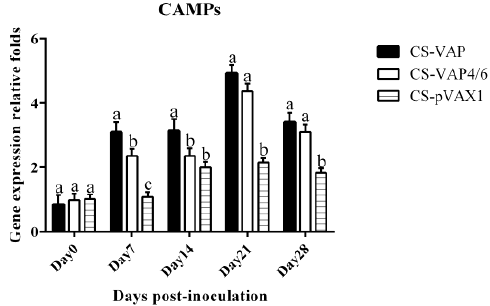
Figure 9. Changes of CAMP gene in blood of experimental mice. It was remarkable that CS-VAP and CS-VAP4 / 6 got significant increases at 7, 21, and 28 days compared with CS-pVAX1 ( p <